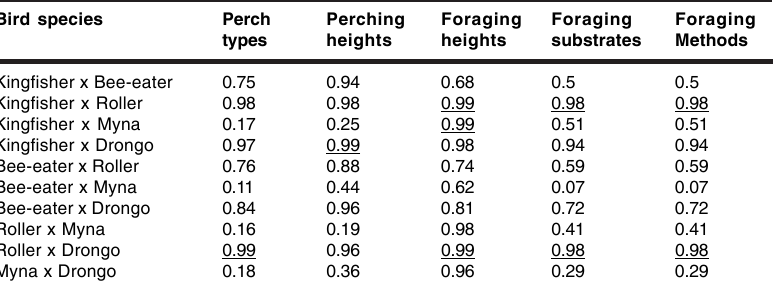
Table 5. Niche overlaps values among the insectivorous birds in the study area Bird species Perch Perching Foraging Foraging Foraging types heights heights substrates